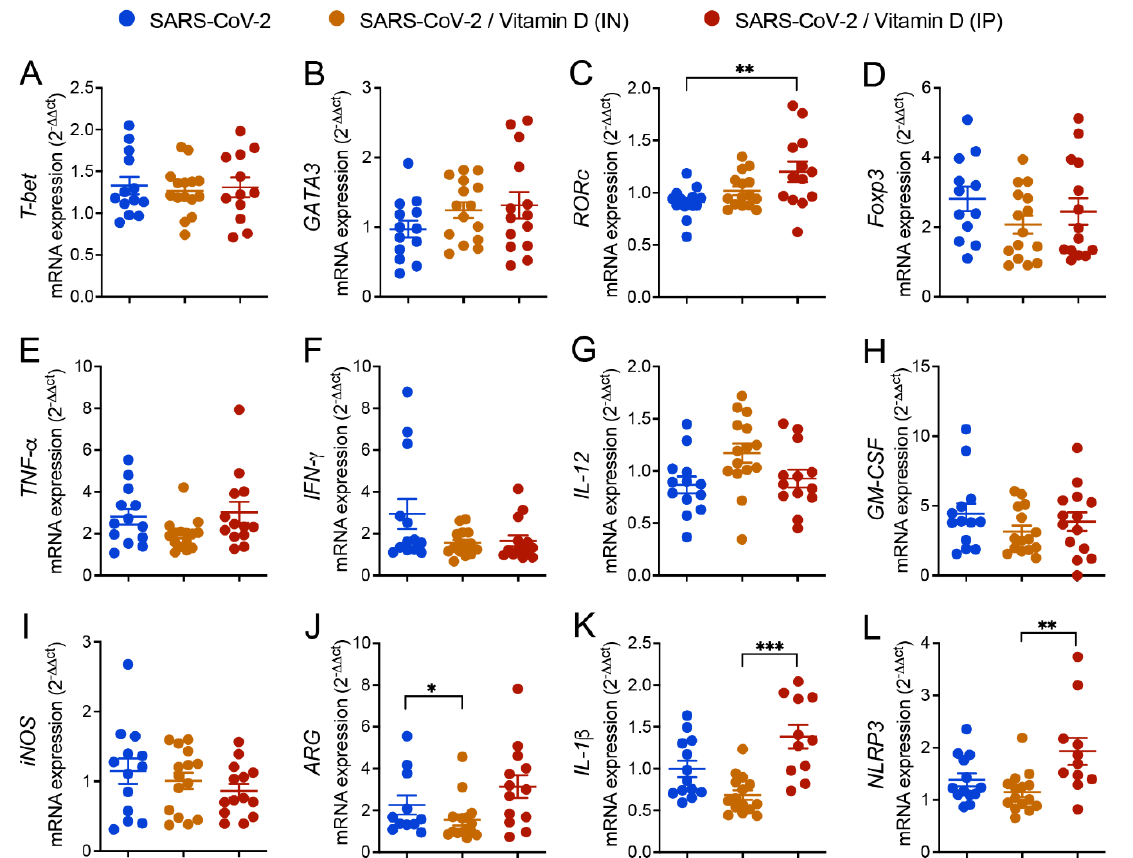
Figure 4. Effect of IN and IP VitD delivery on T cell transcription factors, cytokines, and inflamma- some gene transcripts in lungs of mice IN challenged with UV-inactivated SARS-CoV-2. C57BL/6 mice were instilled with the virus (3 doses of 4 × 10 5 PFU/each) on days 1, 3, and 5. In the IN protocol, mice were treated with 3 VitD doses (0.1 µ g/dose) simultaneously with the SARS-CoV-2 inoculum. In the IP protocol, each animal was treated with 4 VitD doses delivered on days 0, 2, 4, and 6. On the 7th day, the lower left lobe was removed, and the RNA extracted and submitted to RT-PCR. Tested genes included T - bet ( A ), GATA3 ( B ), RORc ( C ), Foxp3 ( D ), TNF - α ( E ), IFN - γ ( F ), IL - 12 ( G ), GM - CSF ( H ), iNOS ( I ), ARG ( J ), IL - 1 β ( K ), NLRP3 ( L ). Data derive from three experiments with similar